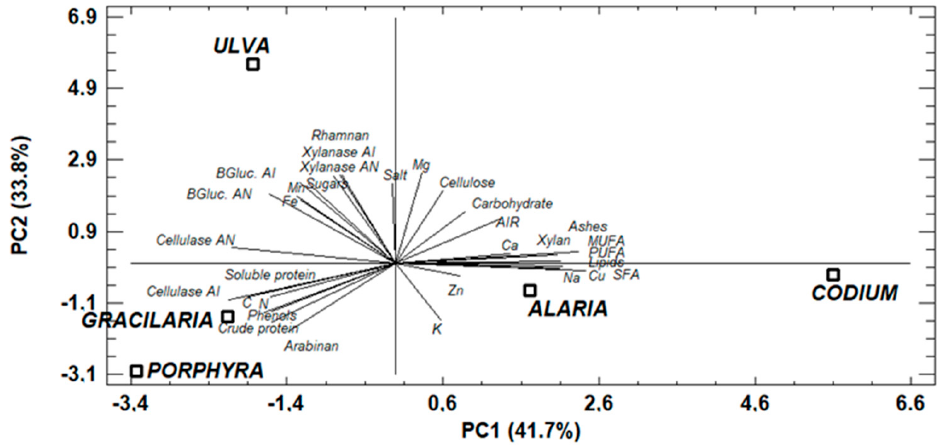
Figure 6. Biplot graph of the principal components analysis to relate seaweed composition and enzyme production during SSF. (AN: A. niger ; AI: A. ibericus ; AIR: acid insoluble residue; SFA: saturated fatty acids; MUFA: monounsaturated fatty acids; PUFA: polyunsaturated fatty acids; BGluc.: β -glucosidase)